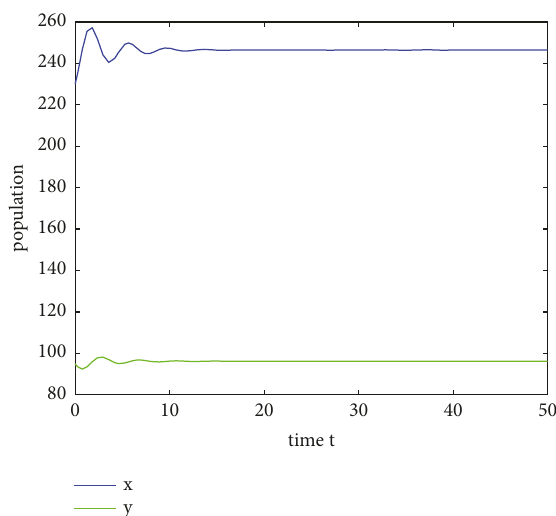
x Figure 8: A Time series diagram for prey and predator. The figure depicts local stability of the interior equilibrium for the delayed model (3) with the time delays 𝜏 1 = 0.1 and 𝜏 2 = 0 , where the other parameter values are 𝑥(0) = 230 , 𝑦(0) = 95 , 𝐴 = 0.01 , 𝑟 = 2.65 , 𝐾 = 900 , 𝑎 = 0.02 , 𝑐 = 0.215 , and 𝑚 = 1.06